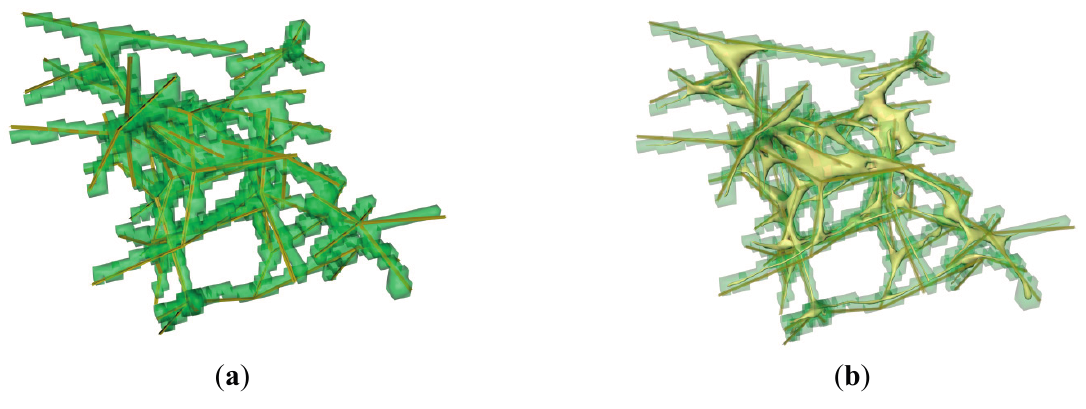
Figure 6. Voxel-based generation of the FRC network. ( a ) Initial local structure; ( b ) Smoothed solid model of the local